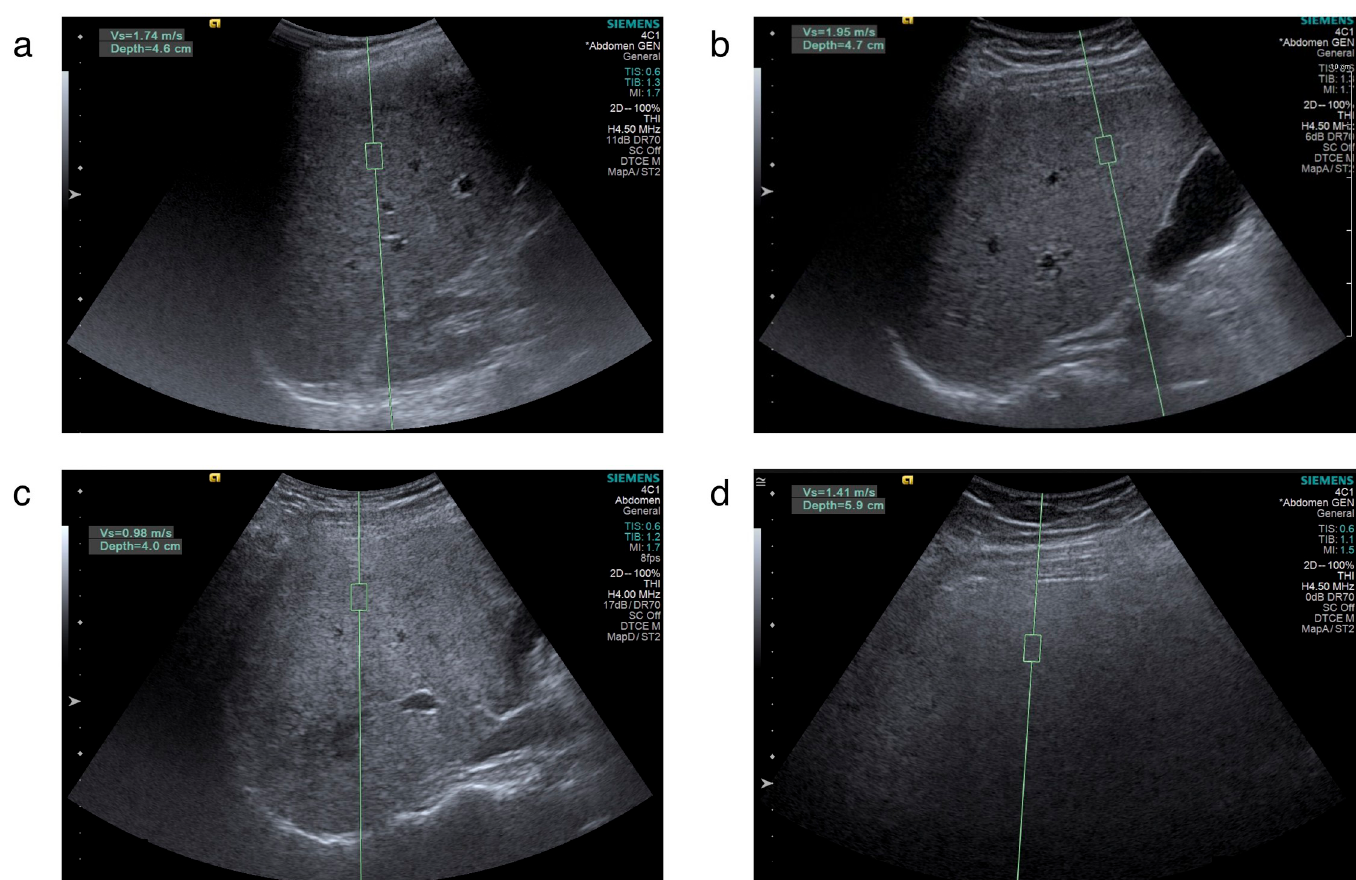
Fig 2. Examples of point shear wave elastography (pSWE) measurements. pSWE measurements in 4 different patients: (A) steatosis grade S0, (B) steatosis grade S1, (C) steatosis grade S2, and (D) steatosis grade S3. Green rectangles indicate regions of interest where measurements are performed.